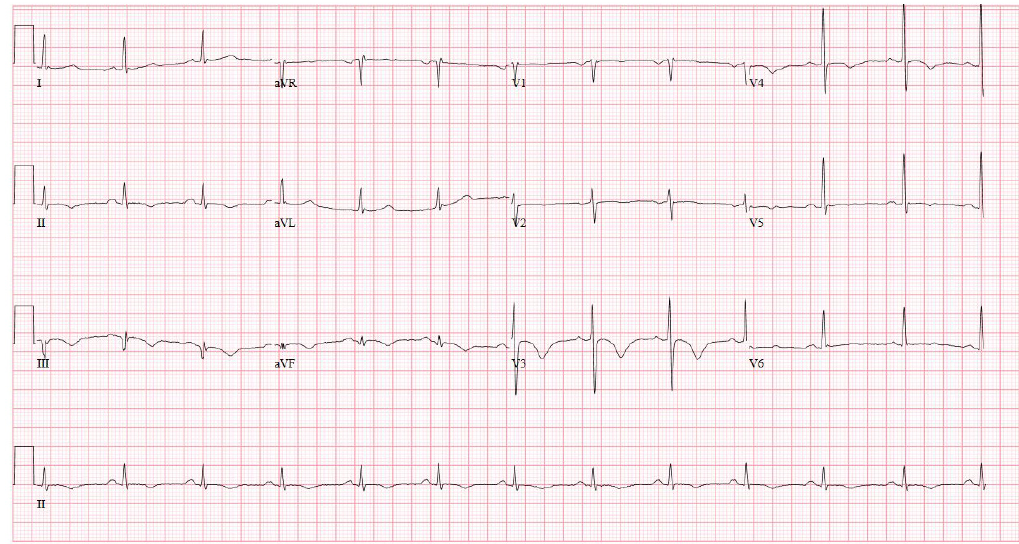
Figure 2. Repeat EKG now showing a Q